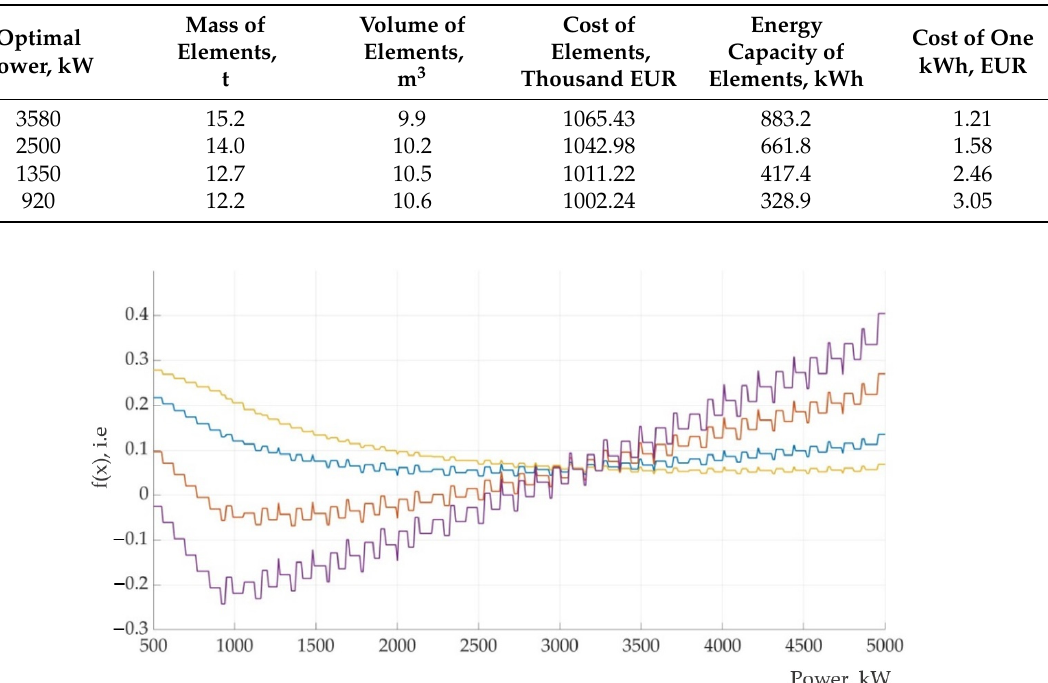
Table 7. Results of calculations of ES parameters.